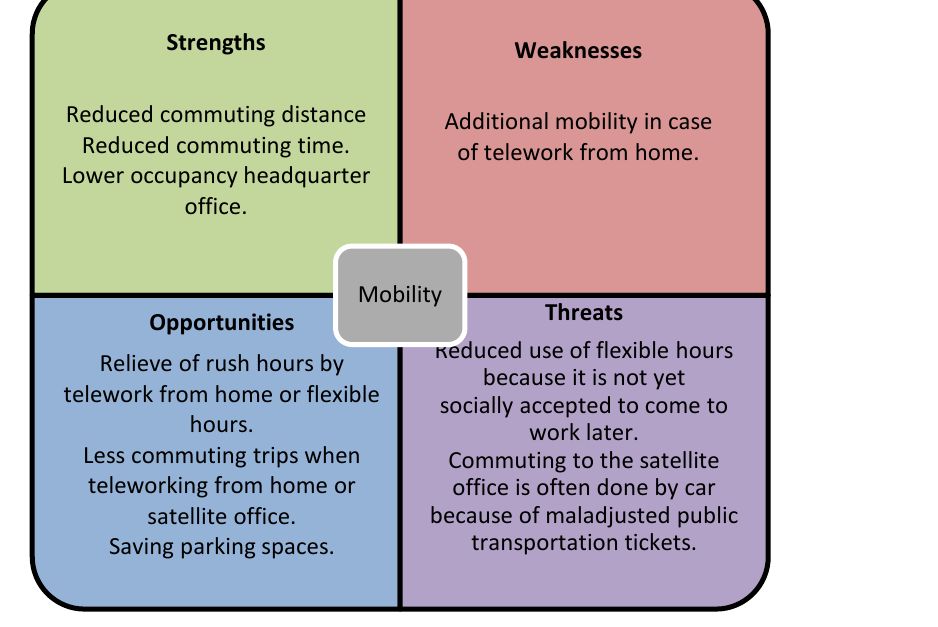
Figure 2. SWOT analysis of the impact of teleworking on mobility (MOBI, 2012)